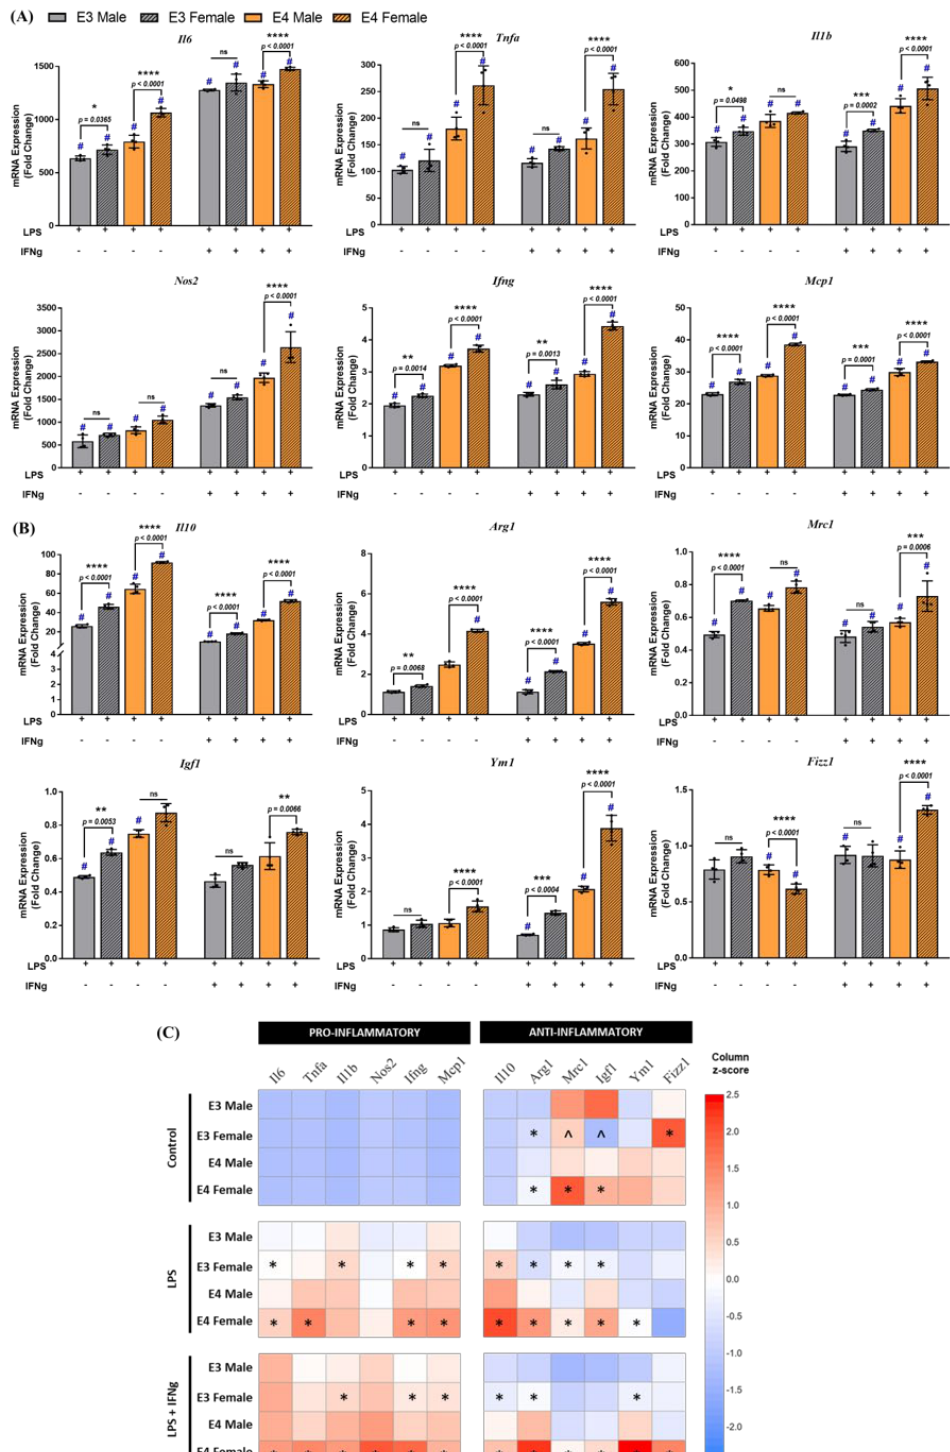
Figure 6. Gene expression in sex-specific microglia is dependent on both the APOE genotype and sex: ( A ) pro − and ( B ) anti − inflammatory gene expression was evaluated in sex − specific microglia from APOE3 and APOE4 genotypes following LPS or LPS + IFNg treatment for 6 h. Gene expression between genotypes and sexes was analyzed using a three − way ANOVA (N = 3 isolations, n = 6 plates) followed by Tukey’s multiple comparisons test. Each data point represents the average mRNA expression from one isolation. Data are represented as the mean ± standard deviation. # denotes a significant increase compared to the respective genotype control (data not included in the